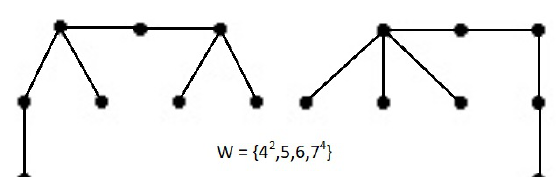
Figure 5. Two non-isomorphic caterpillars having the same weight